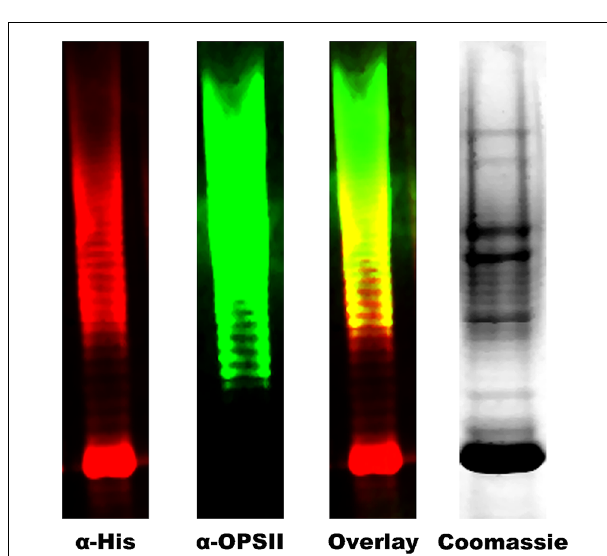
FIGURE 4 |Analysis of purifiedAcrA byWestern Blot. SDB1 transformed with pMAF10 ( pglB ), pIH18 ( acrA ), and pEQ3 (OPS II) were grown ( + / − ) induction of OPS II, harvested, and AcrA was purified by Ni 2 + -NTA affinity chromatography. Purified glycoconjugate was separated on 10% SDS-PAGE and analyzed by western blot (5 μ l) or Coomassie stain (15 μ l). A high-molecular-weight ladder is co-detected by both α -His and α -Glycan antibodies, and overlap of the two signals strongly suggests glycosylation of AcrA. Staining of the purified protein is observed by Coomassie stain.